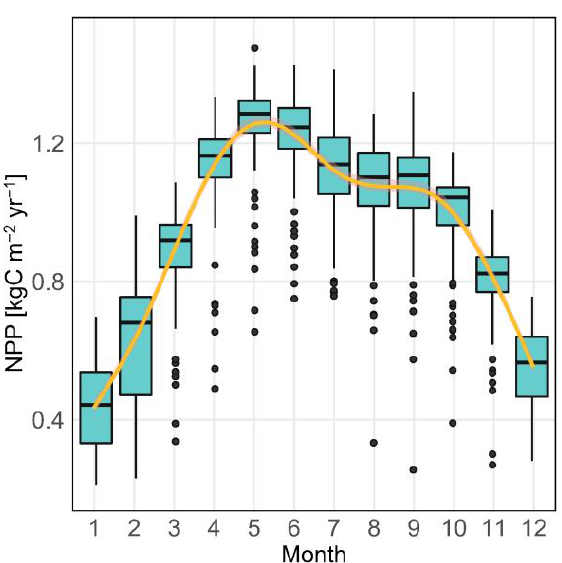
Figure 1. Monthly ED-2.2 simulated NPP [kgC m − 2 yr − 1 ] for averages of 10 forest inventory plots from 2005 to 2021 in the study. Boxplots were based on 10 plots simulation results for 12 months. Black points indicate outliers.